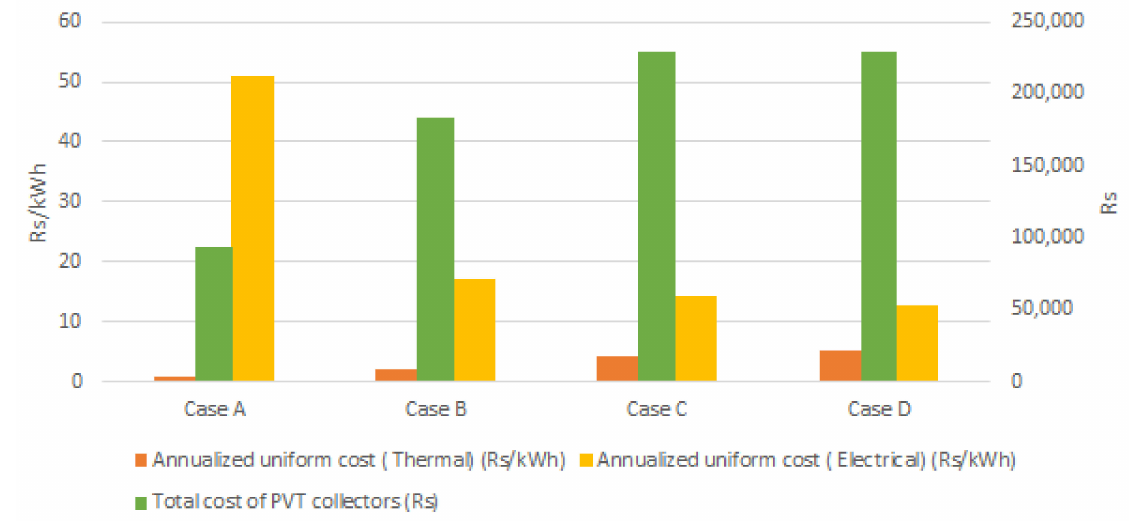
Figure 34. Annualized uniform cost of different PVT configurations (data taken from [77]).